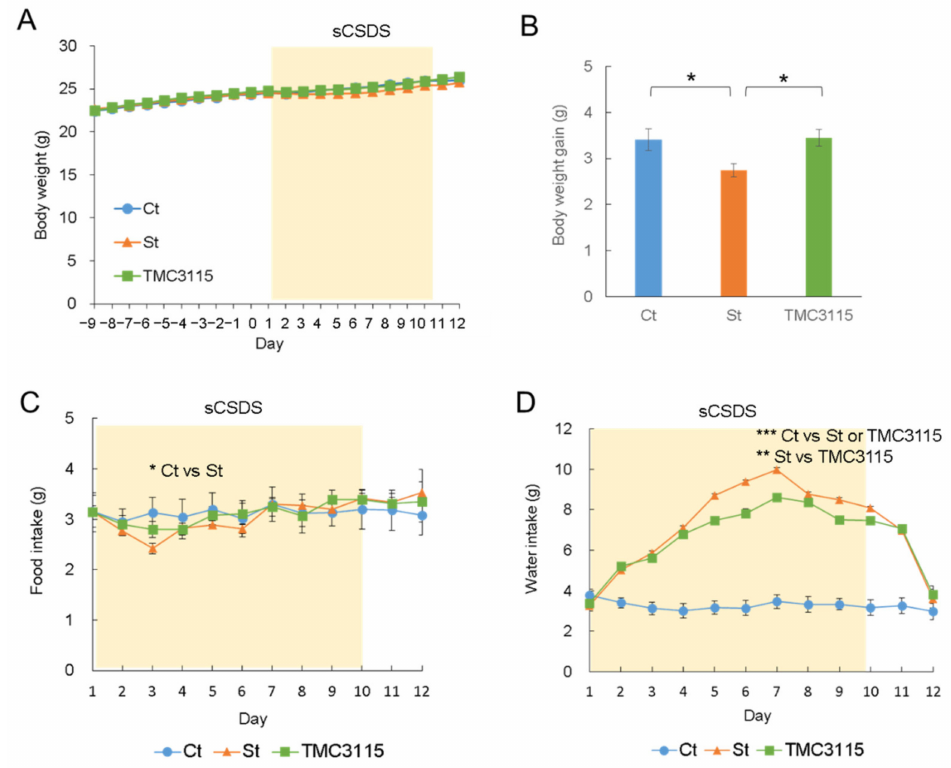
Figure 2. Body weight during the experiment ( A ), body weight gain after the experiment ( B ), and changes in food intake ( C ) and water intake ( D ) during the sCSDS period. Control mice (Ct group): circle; unsupplemented sCSDS mice (St group): triangle; sCSDS mice supplemented with TMC3115 (TMC3115 group): square. Repeated two-way ANOVA with Tukey’s post hoc test was conducted for ( C , D ). Bars represent mean ± SE. * indicates significant post hoc differences between groups, * p < 0.05, ** p < 0.01, *** p <